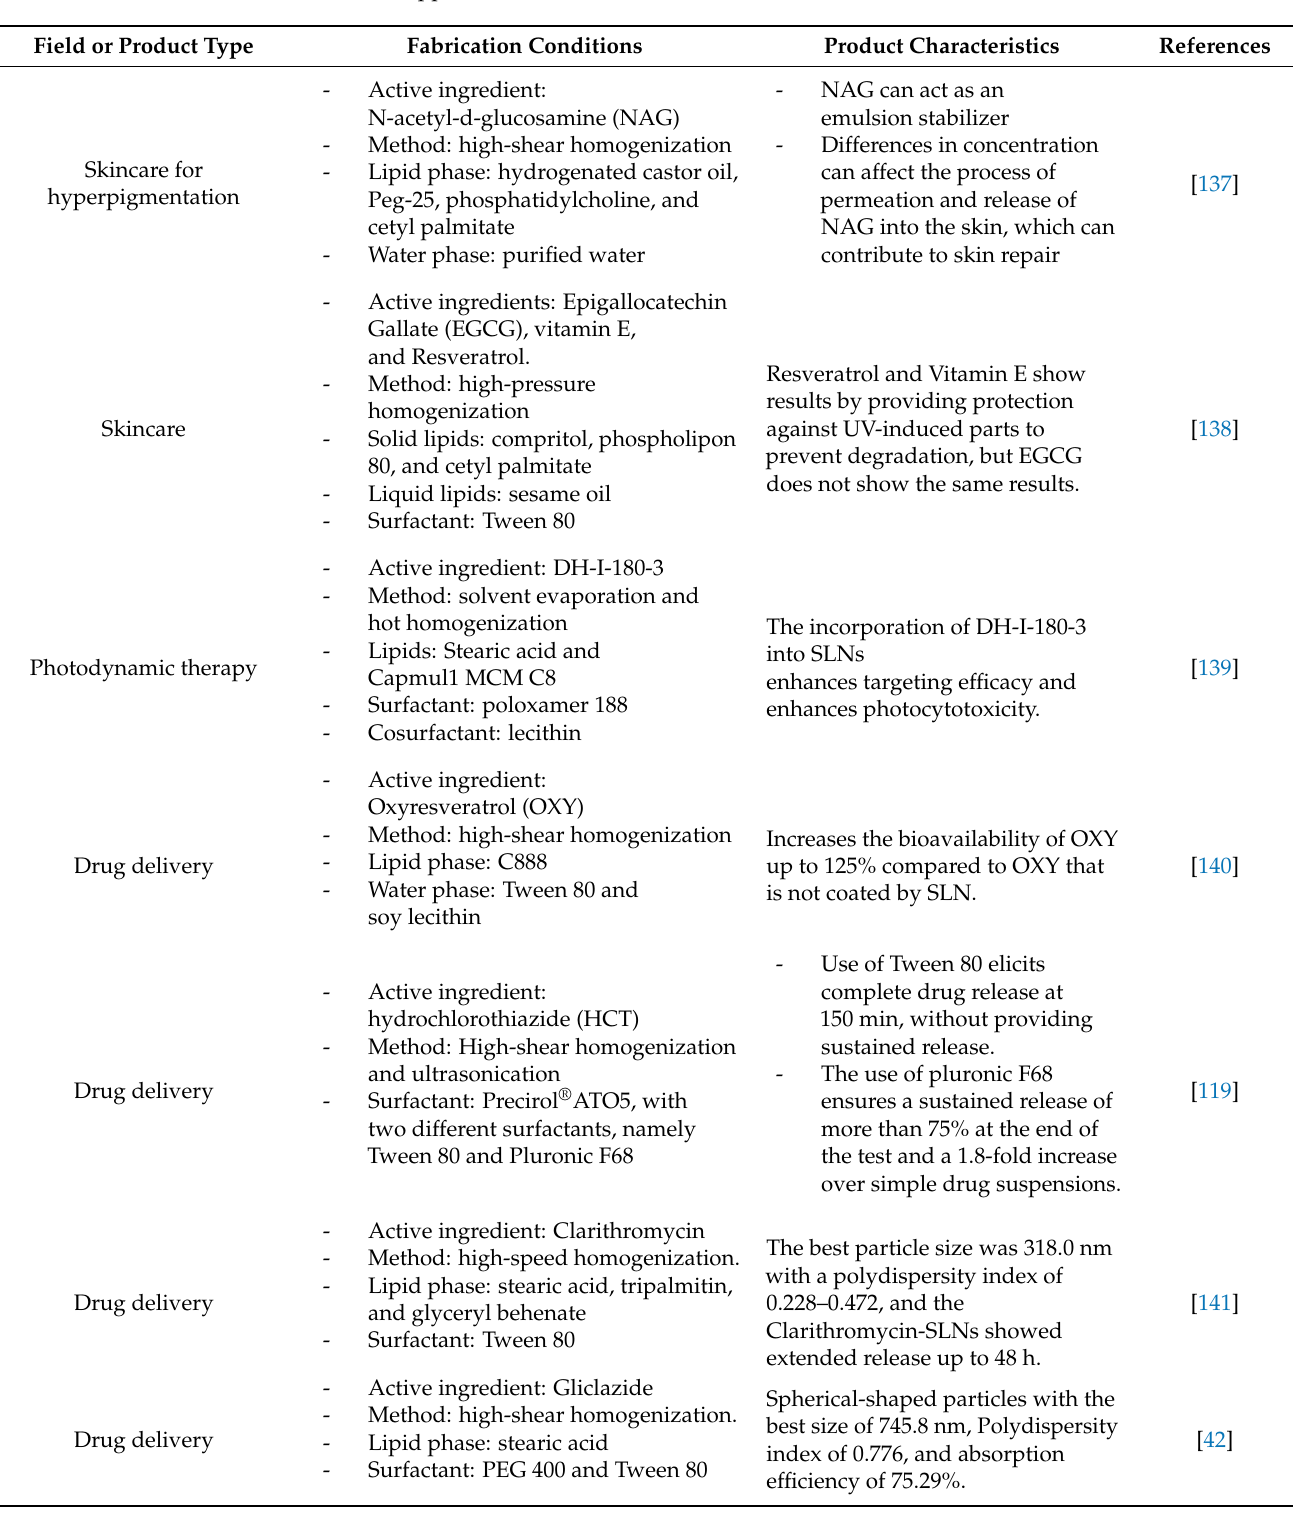
Table 4. Applications of SLNs in various